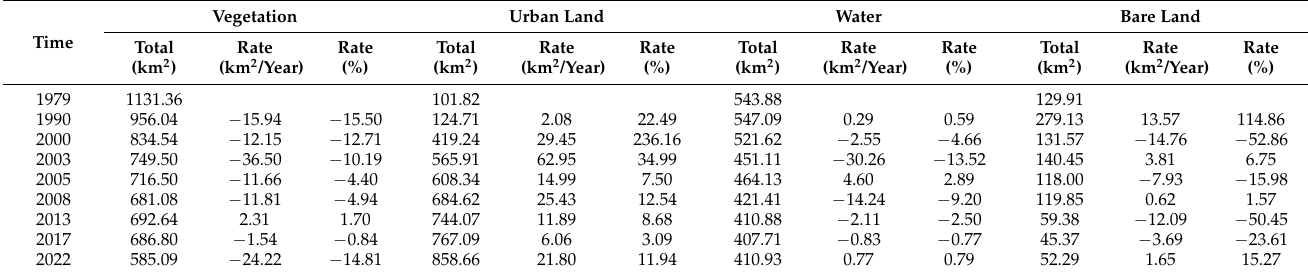
Table 2. Statistics on the land cover of Shenzhen at different